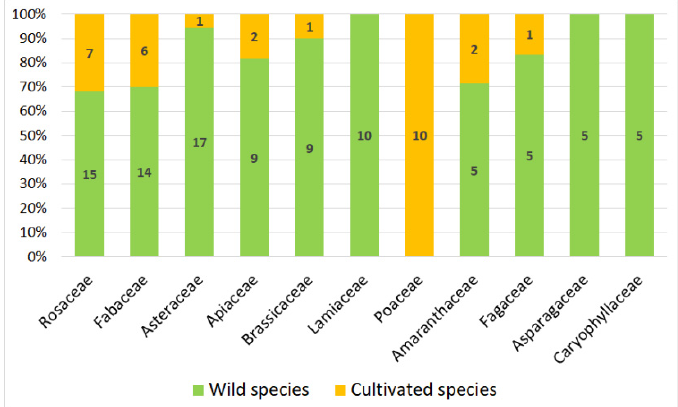
Figure 2. Most represented families: distribution of the 30 cultivated species.